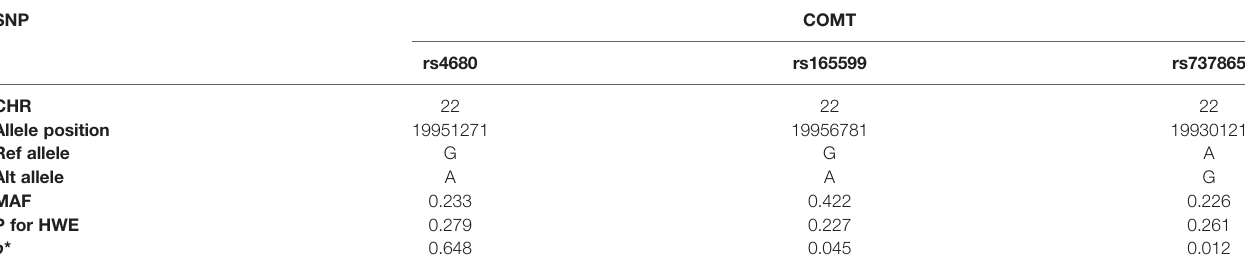
SNP, single-nucleotide polymorphism; CHR, chromosome; Ref allele, loci alleles on the reference sequence; Alt allele, the other allele on the loci; MAF, minor allele frequency (data from 1000 Genomes); HWE, Hardy – Weinberg equilibrium, p-value for HWE in two groups. *p-value for allele frequency differences between two groups.